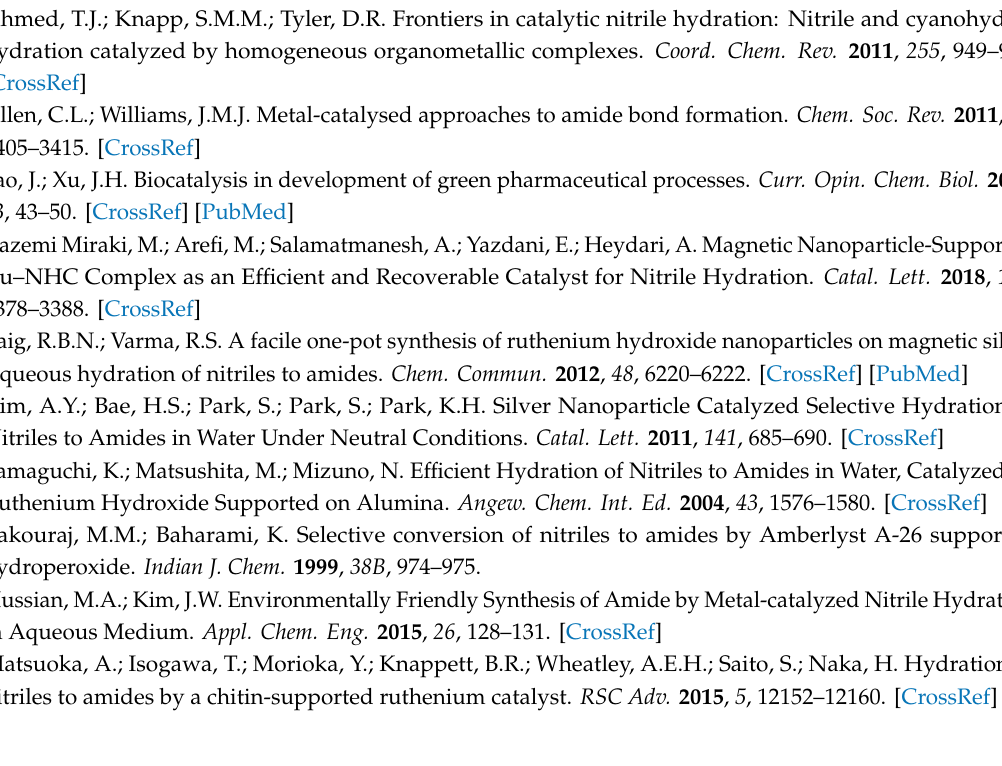
( 4 ) (50% ellipsoid level); Figure S23. ORTEP view of [RhCl(cod)(IPr)]_benzene_ 3 (50% ellipsoid level); Figure